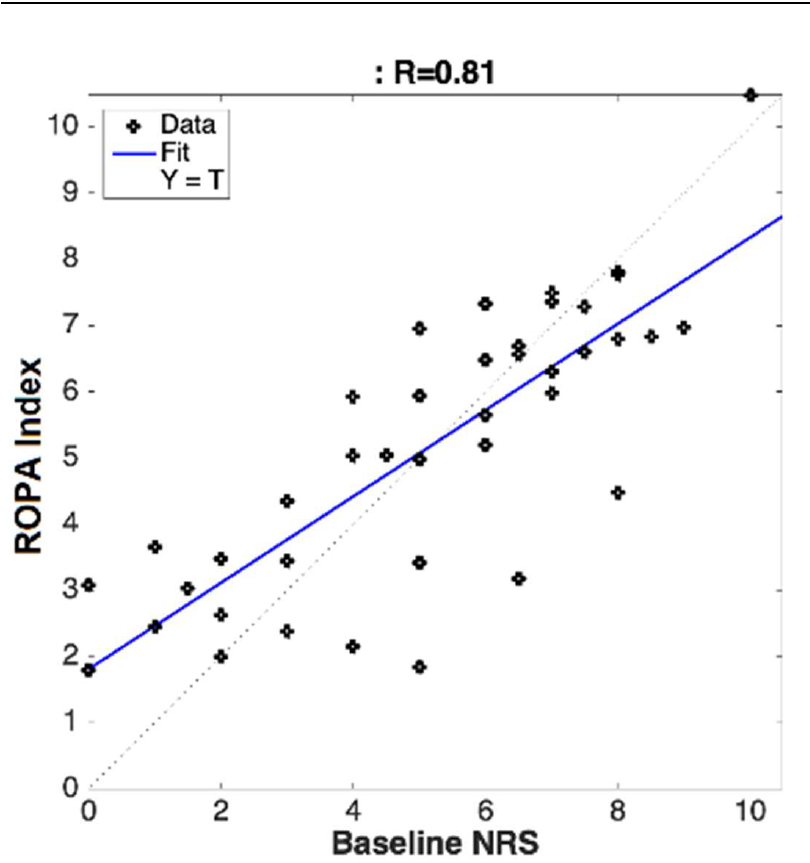
Figure 2. Linear regression between the subject-provided numeric pain rating scale (NRS) at baseline (before the epidural steroid injection) and the objectively measured changes in the physiological parameters responding to pain (ROPA Index).